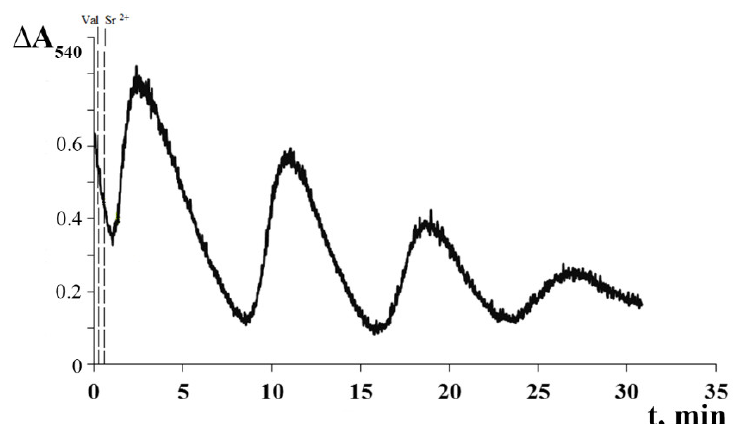
7 of 17 Figure 2. Simultaneous recording of Sr 2+ /valinomycin-induced oscillations in Sr 2+ and K + fluxes and membrane potential of rat liver mitochondria. The medium contained 20 mM sucrose, 1 mM KCl, 1.5 µM TPP + , 1 µM CsA, 1 µM rotenone, 5 mM succinic acid, and 12.5 mM Tris (pH 7.3). Additions: 2 ng valinomycin and 45 nmol SrCl 2 /mg of protein. The typical traces are presented ( n = 5). Along with a temporary dissipation of ΔΨ m , the influx of Sr 2+ and K + ions into mito- chondria was also accompanied by a synchronous decline in the pH out of the medium (al- kalization of the mitochondrial matrix) (Figure S1). The decrease in the electrochemical transmembrane potential was enhanced with each new wave of the oscillations, which ultimately impaired the ability of mitochondria to accumulate Sr 2+ , K + , and H + ions. Our experiments suggest that the number of oscillation waves depends on the degree of cou-